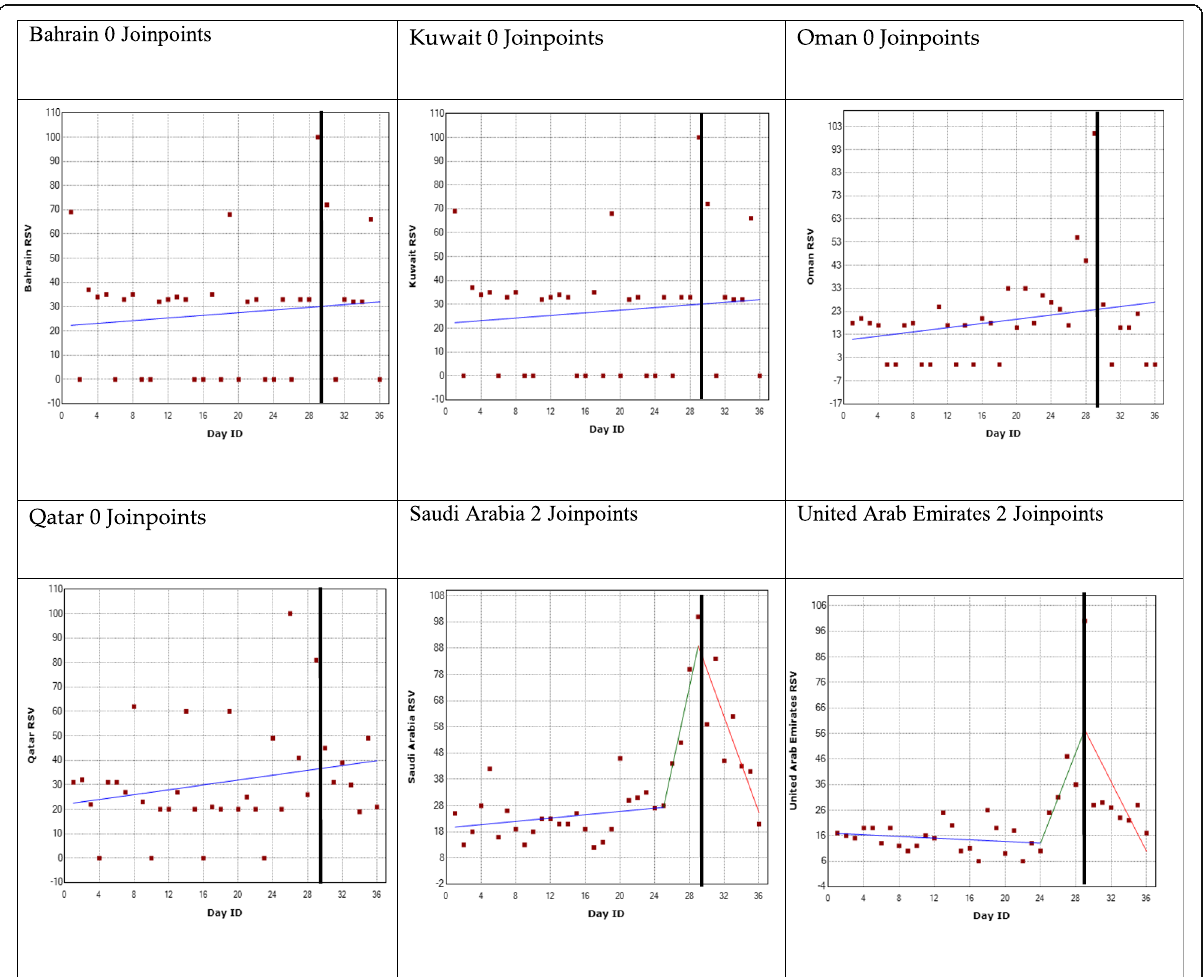
Fig. 3 World Mental Health Day joinpoint regression analysis. *The black vertical line represents the global public health